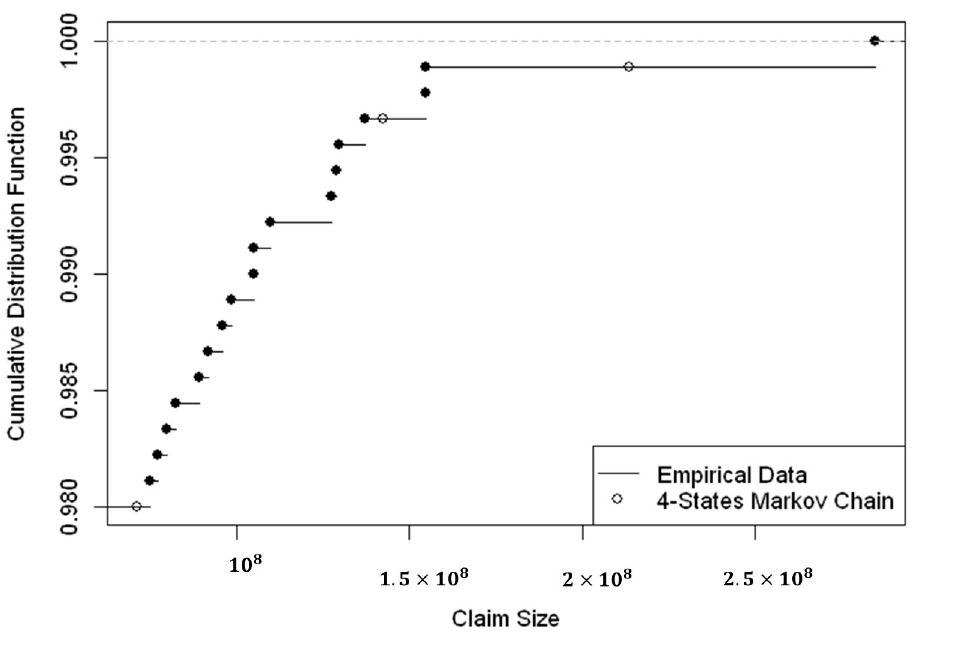
Figure 13. Distribution function of empirical data and 4-states Markov Chain for Group 2 [ ˆ D 2 ( g )